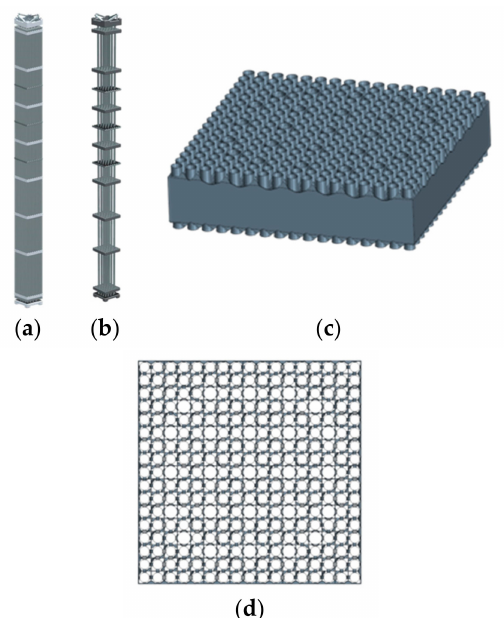
Figure 1. Geometric model of a full-scale fuel assembly: ( a ) the fuel assembly with fuel rods, ( b ) the fuel assembly without fuel rods, ( c ) the main view of the spacer grid, and ( d ) the top view of the spacer grid.